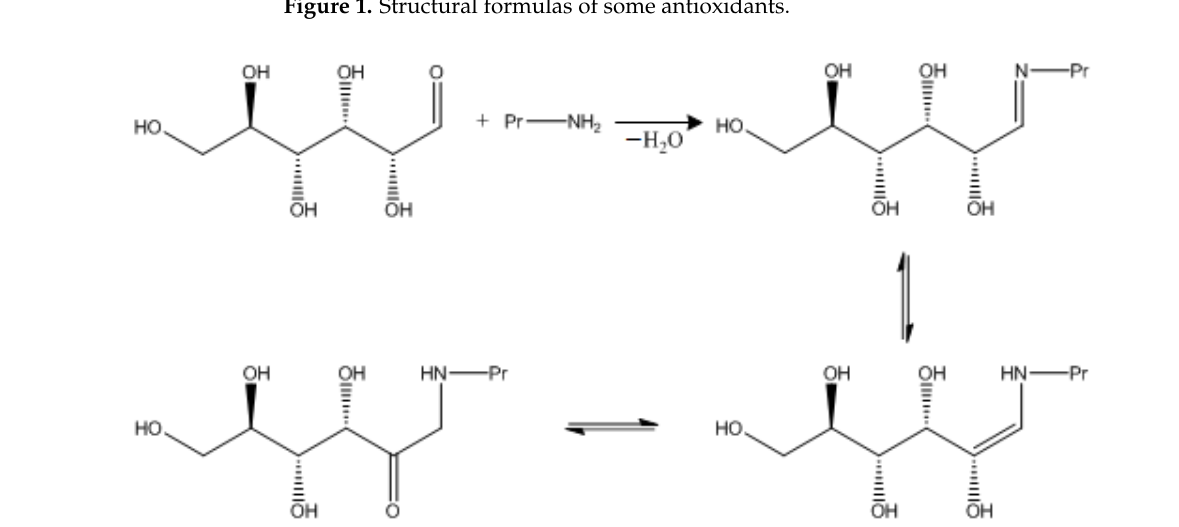
Figure 2. Maillard reaction scheme.